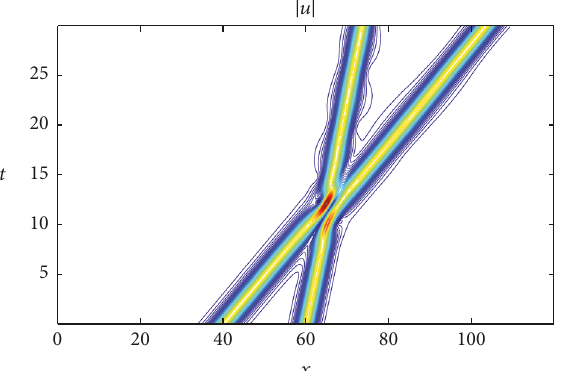
Figure 22: Wave-crest trajectory of collision of the two solitary waves of different speed and amplitude shown in Figure 20.